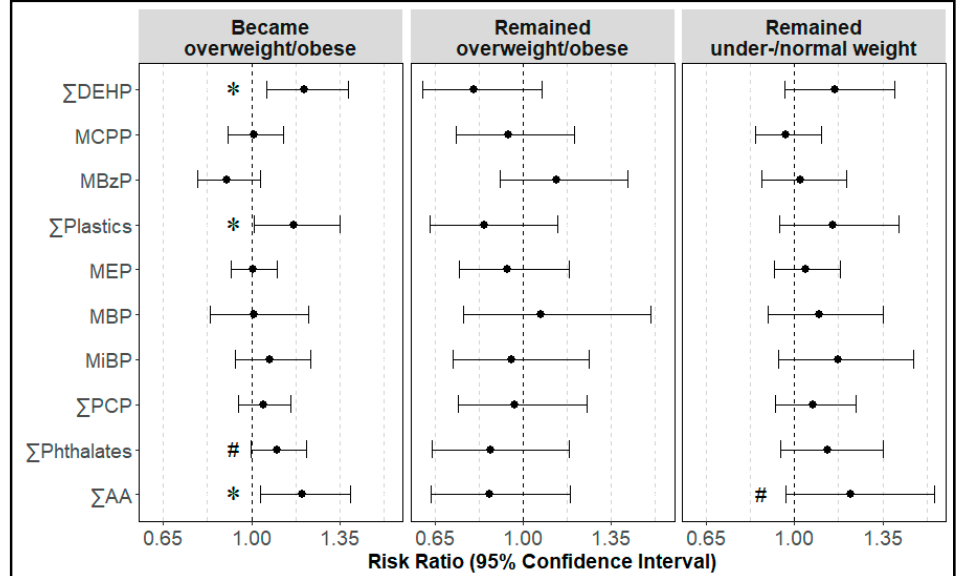
Figure 2. Differences in associations between phthalate biomarker concentrations and uterine fibroids by change in BMI from age 18 to 45–54. Forest plots display risk ratios (filled circle) and 95% confidence intervals (horizonal lines) for the risk of prior fibroid diagnosis for every 2-fold increase in phthalate biomarker concentrations among women who remained overweight/obese ( n = 223 no prior fibroids diagnosis, n = 66 yes prior fibroids diagnosis), became overweight/obese ( n = 135 no prior fibroids diagnosis, n = 47 yes prior fibroids diagnosis), and remained under-/normal weight (n=161 no prior fibroids diagnosis, n = 80 yes prior fibroids diagnosis) from age 18 to 45–54. Models account for race/ethnicity, income, age at menarche, oral contraceptive use, parity, fertility consultation, change in BMI from age 18 to 45–54, and a multiplicative interaction between phthalate biomarker and change in BMI. Confidence intervals that do not cross the null (dashed vertical line) are significant at # p ≤ 0.10 or * p < 0.05. ∑ DEHP = MEHP/278 + MEHHP/294 + MEOHP/292